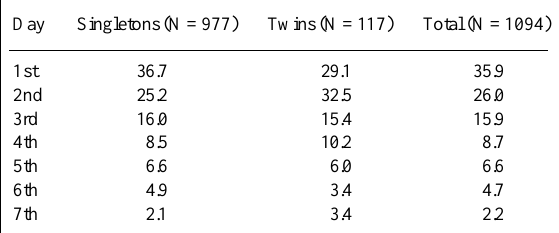
Table III - Distribution (%) of early neonatal deaths among singletons and twins according to the days elapsed from birth.